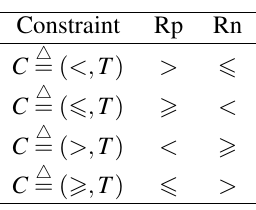
Table 8. Relations for the Open ( C ) function. Depending on the relation B r ∈ { (cid:54) ,<,>, (cid:62) } in the constraint C , the values for Rp and Rn are